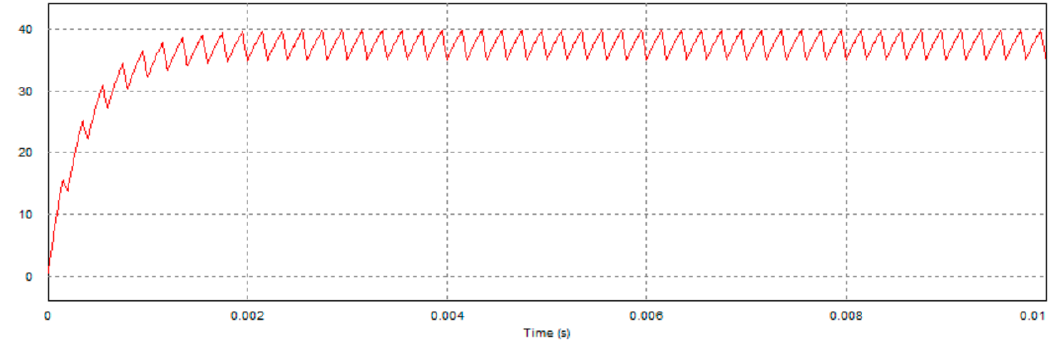
Figure 7. Simulating charge and discharge voltage of 20 µ F capacitor.